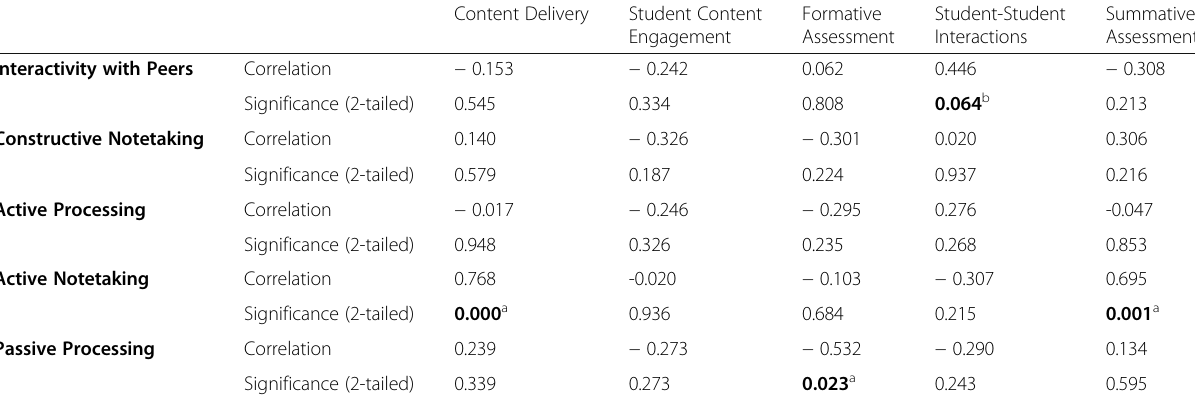
Table 8 Partial correlation matrix of SCCEI and PIPS